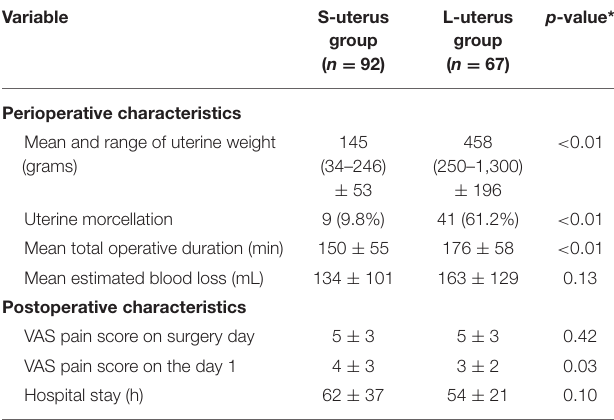
TABLE 2 | Operative characteristics.